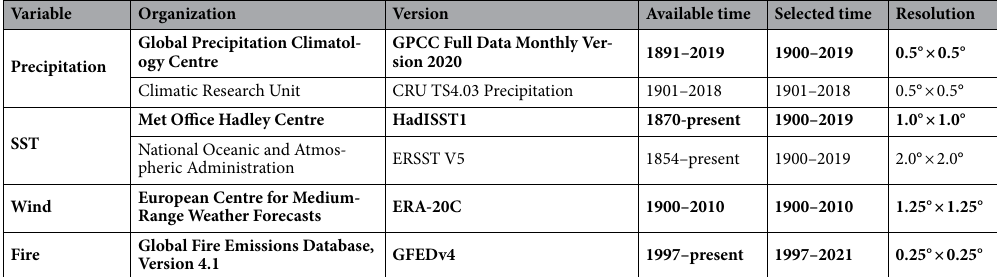
Table 1. The details of selected reanalysis datasets. These datasets used in figures are in bold.